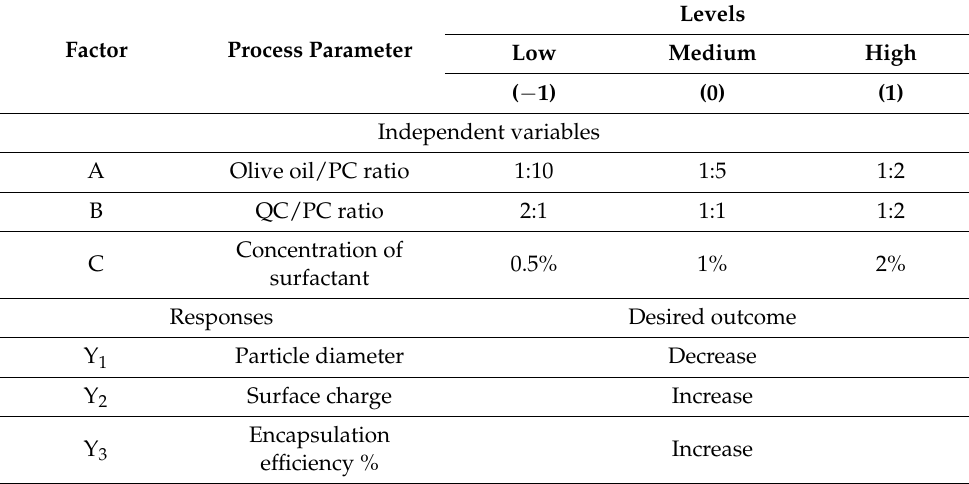
Table 1. Levels of independent variables and responses used in experimental